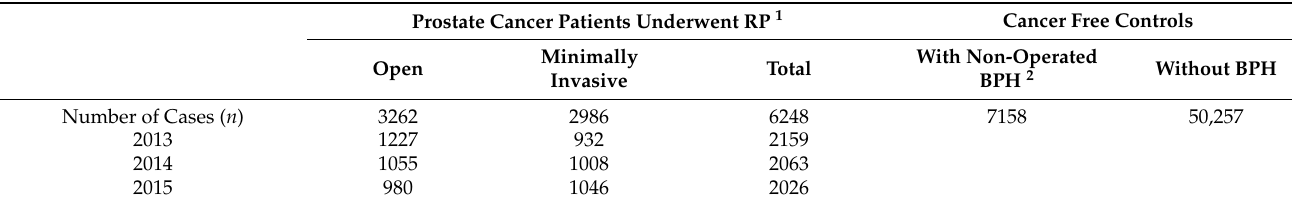
Table 1. Sample characteristics and incontinence pad prescription among prostate cancer patients underwent radical prostatectomy between 2012–2015 in Austria and cancer-free control